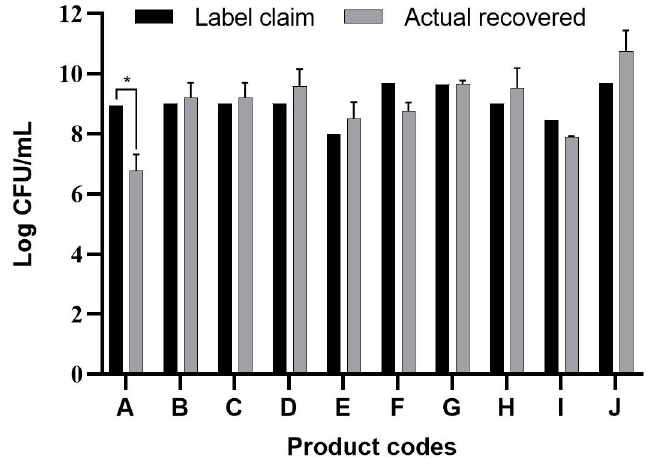
Figure 1. Quantitative label claims versus recovered CFUs from commercial probiotic products intended for children in the Republic of the Philippines (products A–E) and Republic of Korea (products F–J) (* p <